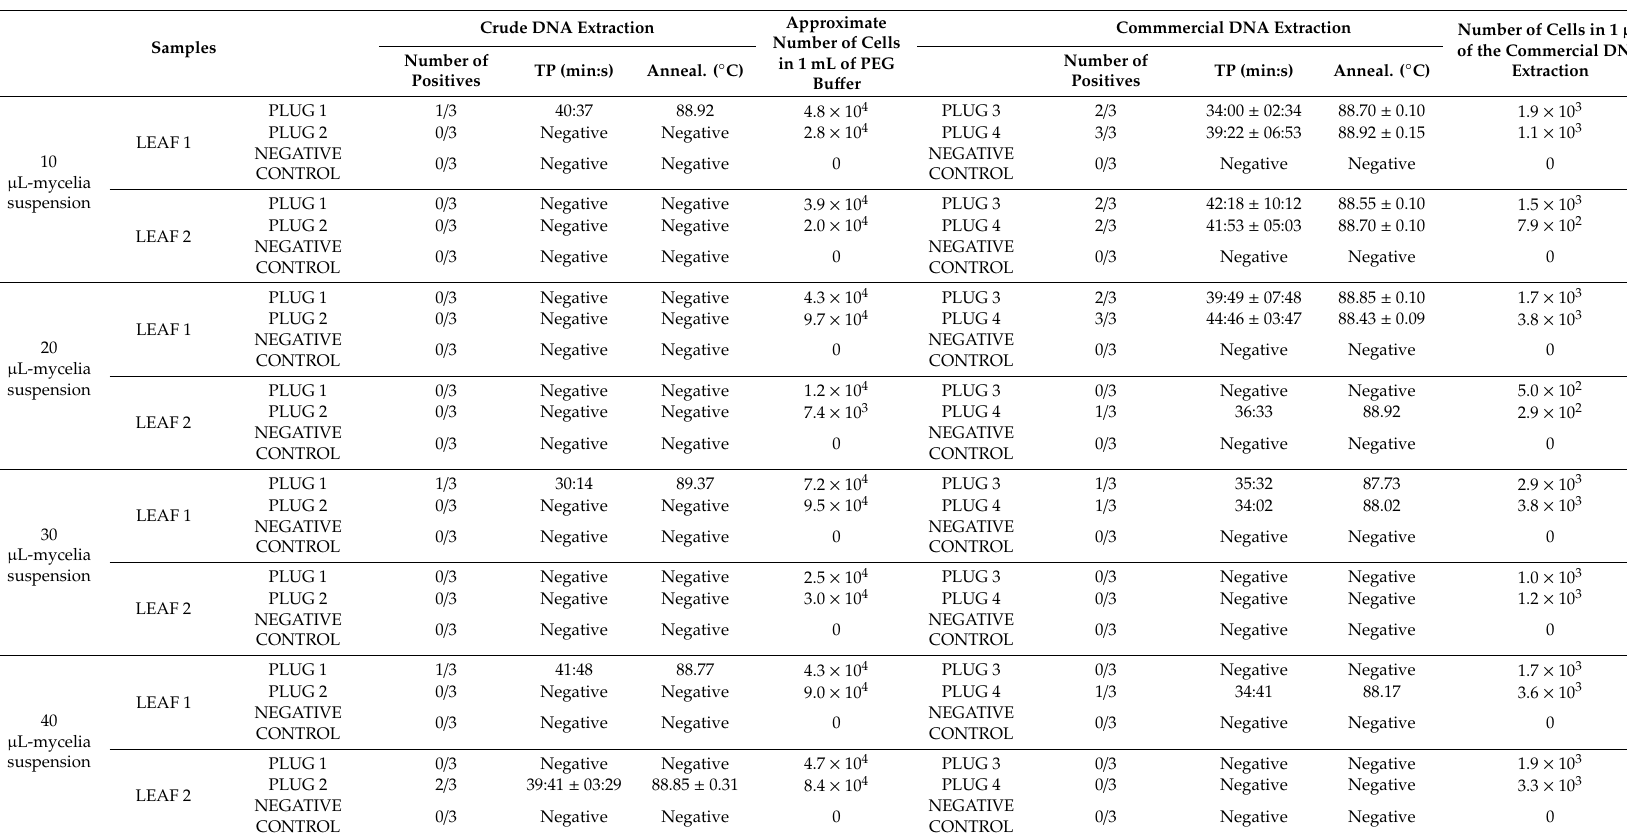
Table 3. Sensitivity testing using di ff erent inoculum volumes and comparison between the LAMP assay performed with both types of DNA extractions (crude extraction and commercial extraction). Approximate number of cells in the crude DNA extraction and in the final elution of the commercial DNA extraction was calculated in other three biological replicates with the qPCR assay. Tp = time to positive, Anneal. = annealing